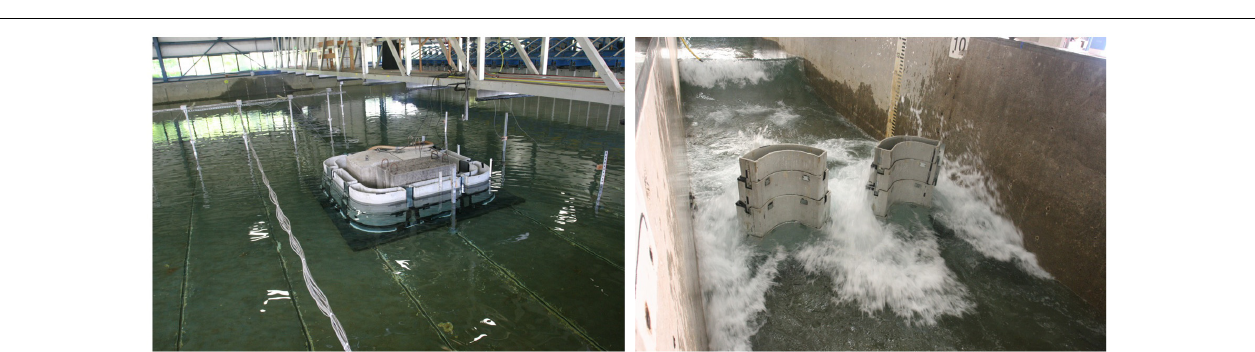
FIGURE 8 | AST shielding tests DWB (left) and detail of a solitary wave impacting an AST (right) .